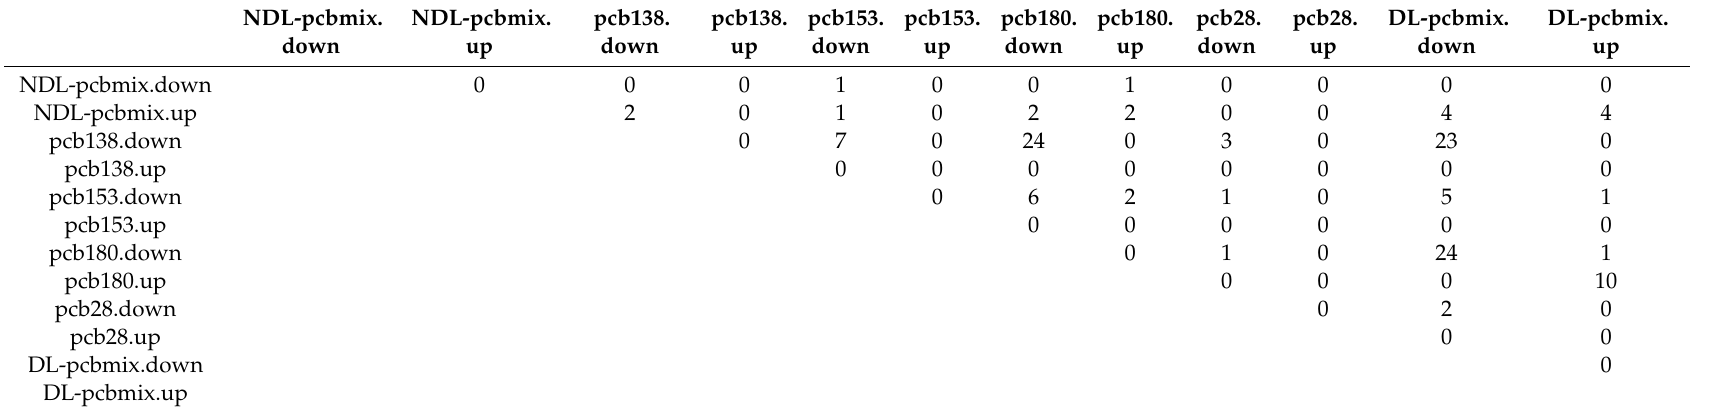
Table 2. Number of common di ff erentially expressed